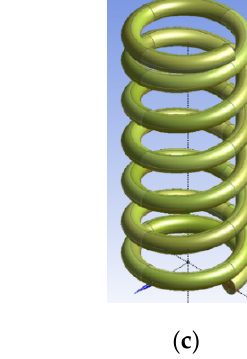
Figure 4. SCDs according to internal diameters: ( a ) 40 mm; ( b ) 50 mm; ( c ) 60 mm.